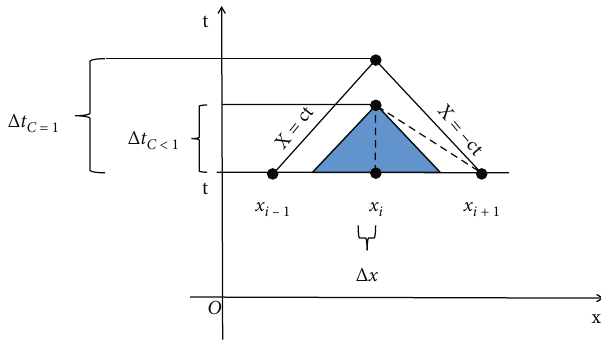
Figure 6: When zero padding is use, the point i − 1 will be set to 0, so the Courant number is an in fi nite number. The blue part in the fi gure is the domain of di ff erence equation. The area enclosed by dotted line represents the domain of zero